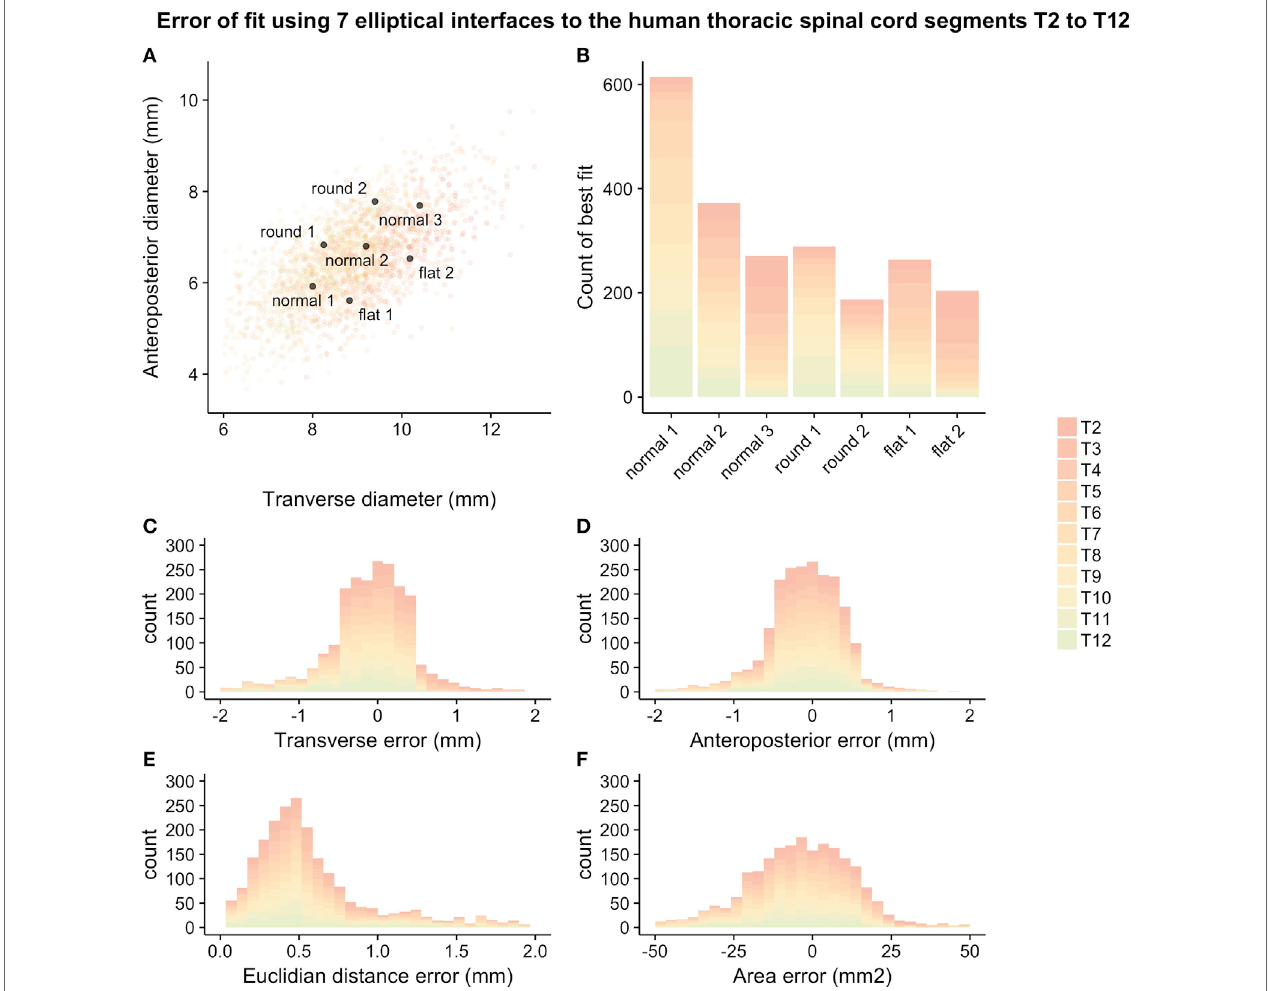
FigUre 3 | Error-of-fit between simulated thoracic spinal cord segments T2–T12 and guiding device sizes represented by seven ellipses: (a) overlay of device sizes and simulated data, (B) best-fitting device for the simulated data, (c) transverse error-of fit, (D) anteroposterior error-of-fit, (e) Euclidian distance error, and (F) area error. For numerical values of the different measures of error, see Table 2